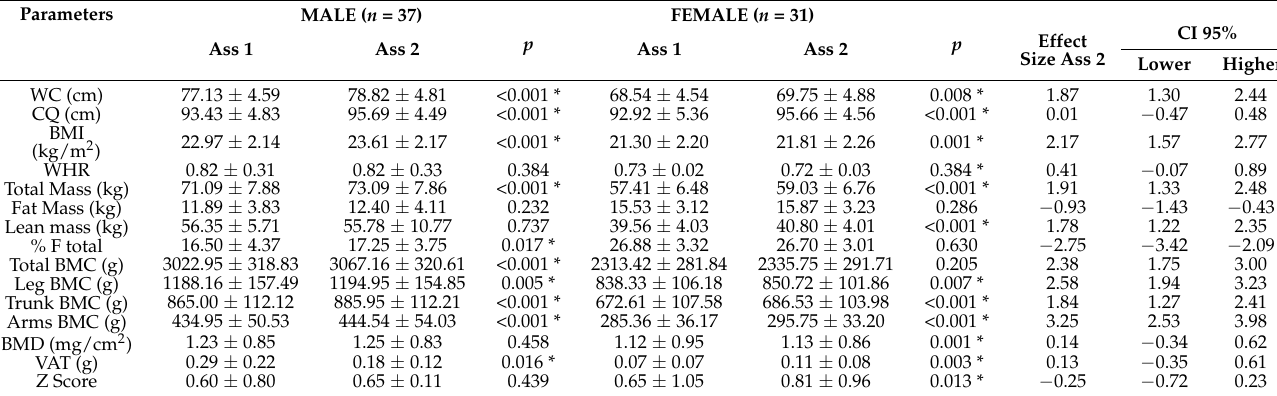
Table 2. Effect of training on anthropometric variables, body composition and bone